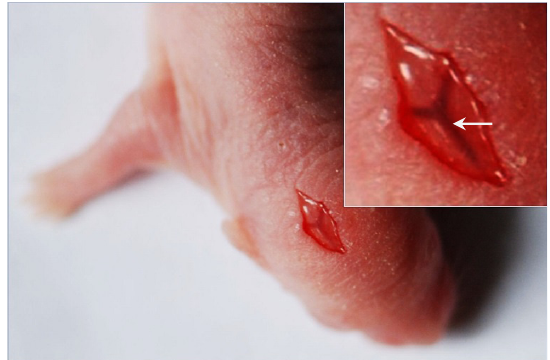
Fig. 1. The imaging of superior sagittal vein in newborn rats through fontanel. The arrow shows the main trunk cerebral